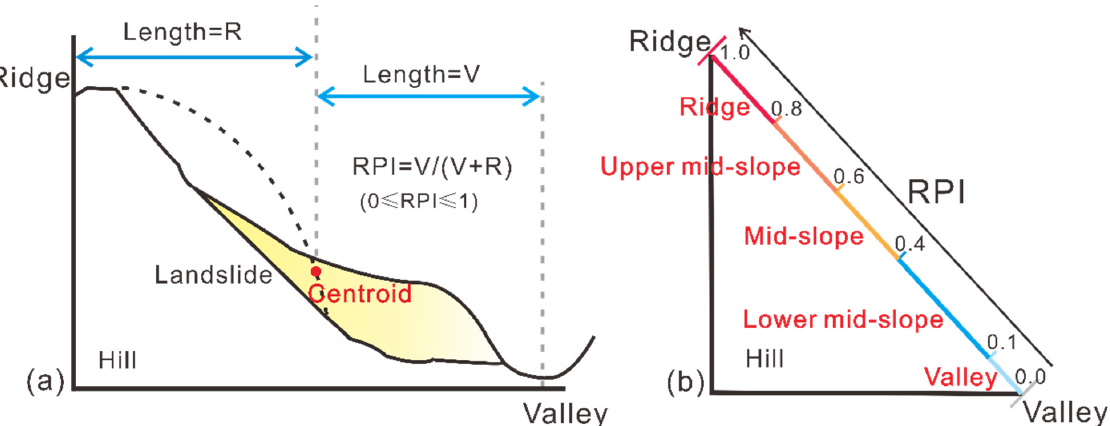
Figure 6. Definition of the RPI (relative position index) ( a ) and the different RPI values representing the different hill sections ( b ). The RPI values of [0.0–0.1), [0.1–0.4), [0.4–0.6), [0.6–0.8), [0.8–1.0] represent the valley, lower mid-slope, mid-slope, upper mid-slope and ridge, respectively, of a hill.